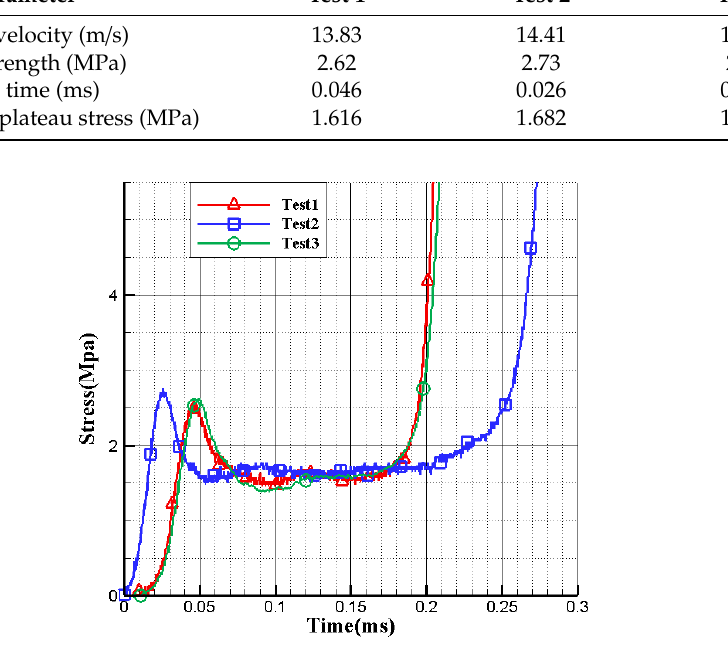
Figure 8. Stress–time curve of direct impact tests and SHPB test.